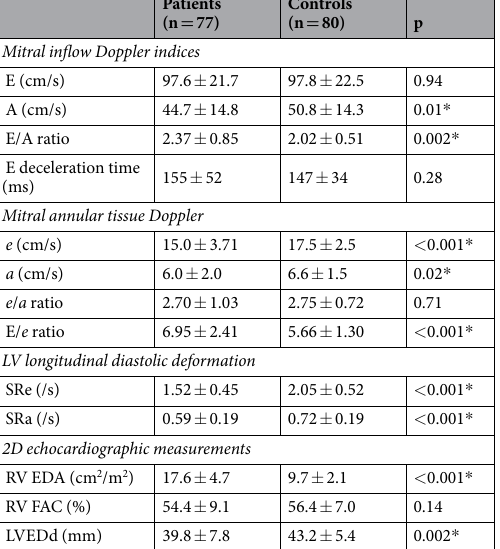
Table 2 summarized the correlation analyses of LV DWS and stiffness index. Left ventricular DWS was found to correlate negatively with E/ e ratio (p < 0.001) and RV end-diastolic area